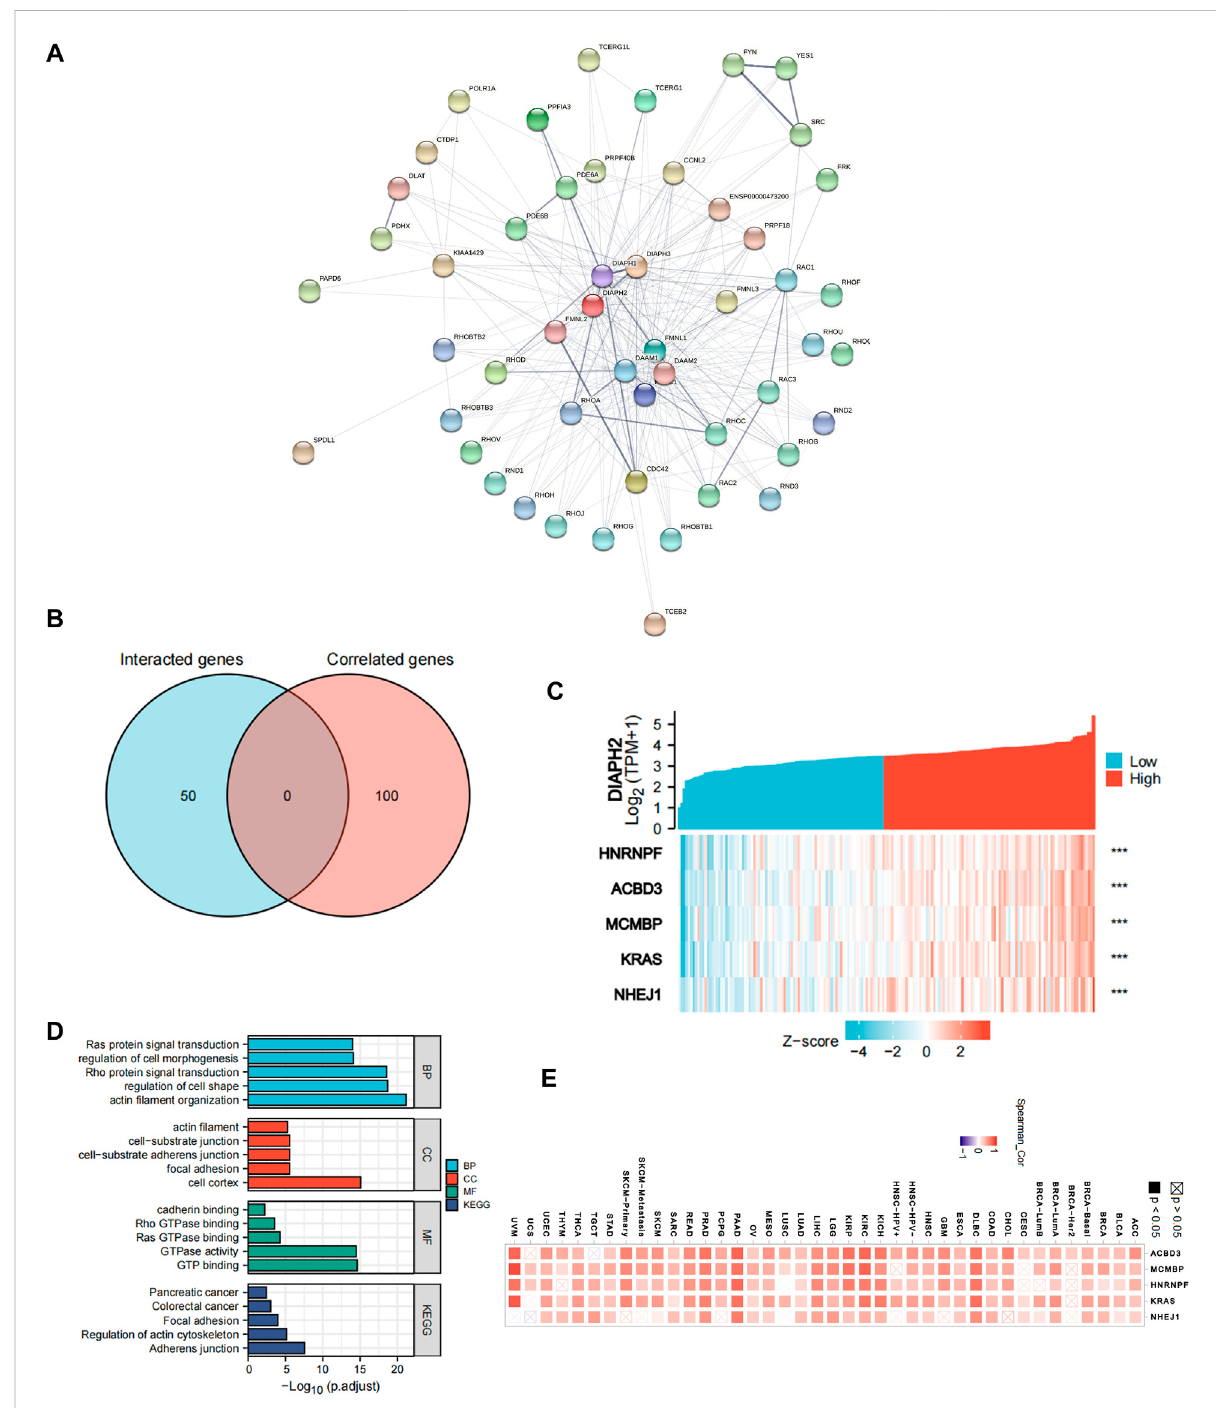
FIGURE 5 DIAPH2-related gene network, KEGG pathway analysis, and GO enrichment analysis. (A) A total of 50 available experimentally determined DIAPH2-interacting proteins using STRING tool. (B) An intersection analysis of the DIAPH2-interacting and -correlated genes. (C) The correlation between DIAPH2 expression and the top fi ve DIAPH2-correlated genes expression in PAAD. *** p < 0.001, in Spearman ’ s rho. TPM, transcripts per million. (D) GO enrichment and KEGG pathway analyses based on the DIAPH2-interacting and -correlated genes. Adjusted p -values were obtained from multiple hypotheses test using the Benjamini – Hochberg procedure; p . adjust < 0.05 was considered statistically signi fi cant. (E) Correlation between DIAPH2 and top fi ve DIAPH2-correlated genes expression in pan-cancer, in purity-adjusted partial Spearman ’ s